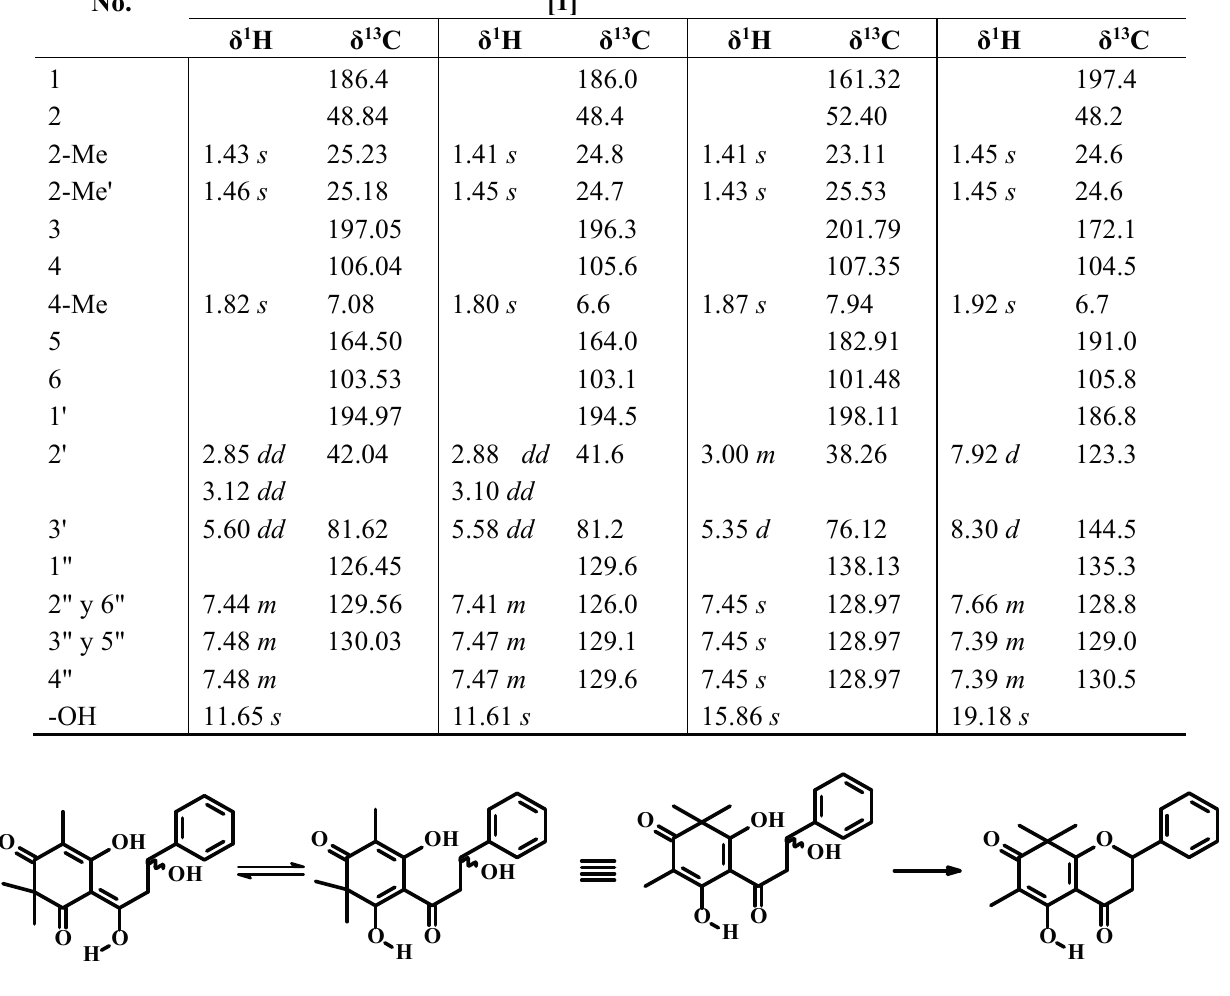
Figure 3. Proposed biosynthesis from Champanone D to Champanone